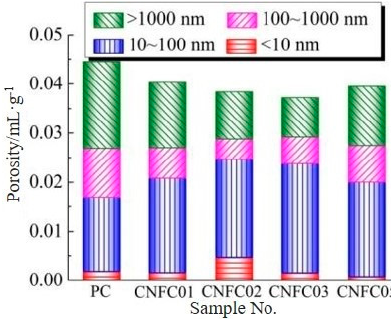
Figure 15. Proportion of various pores.